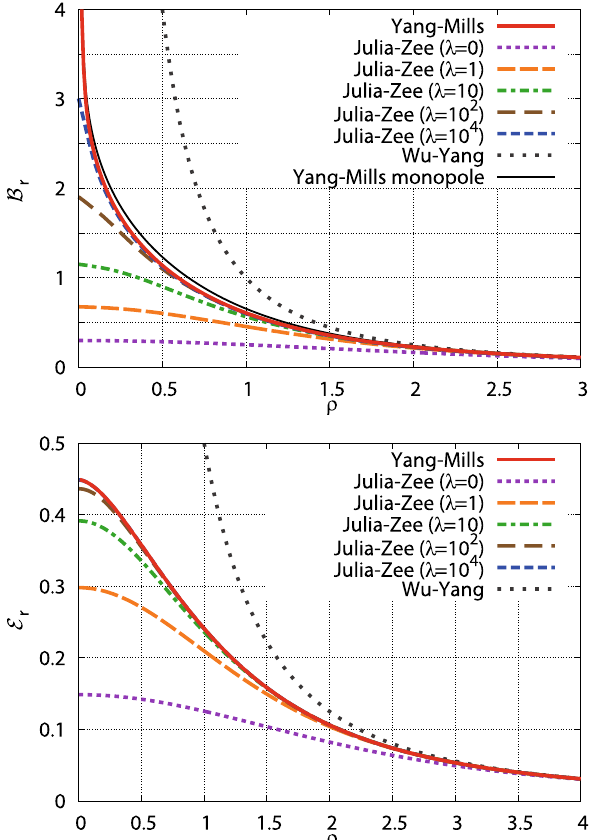
Fig. 6 The energy density e of the Yang–Mills dyon as a function of ρ = g v r at C = 0 . 5 to be compared with the Julia–Zee dyons for λ = 0 , 1 , 10 , 10 2 , and 10 4 , where the Wu–Yang monopole and the Yang–Mills monopole are also plotted for reference. 0 ≤ ρ ≤ 6 (top panel), 0 ≤ ρ ≤ 0 . 6 (bottom